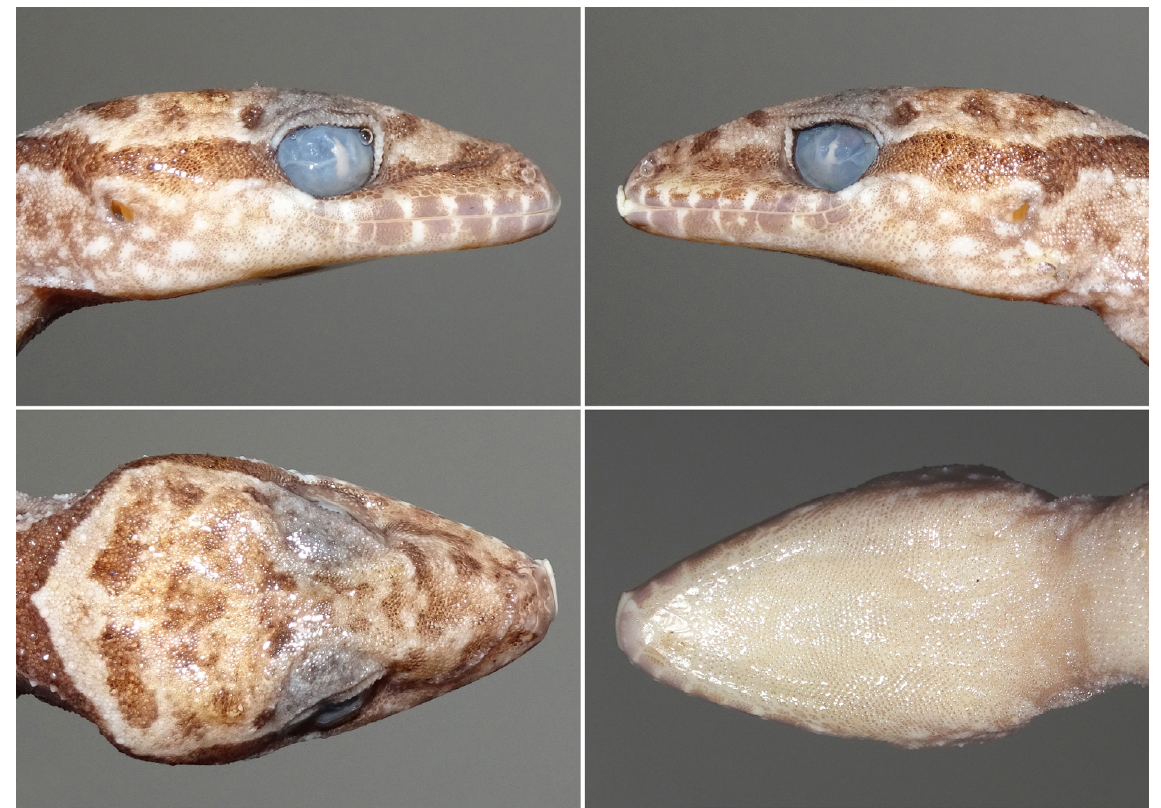
Fig. 8. Cyrtodactylus chungi sp. nov., paratype, ♀ (IEBR 4582). Head views in preservative. Top: lateral view. Bottom left: dorsal view. Bottom right: ventral view. Photos T.